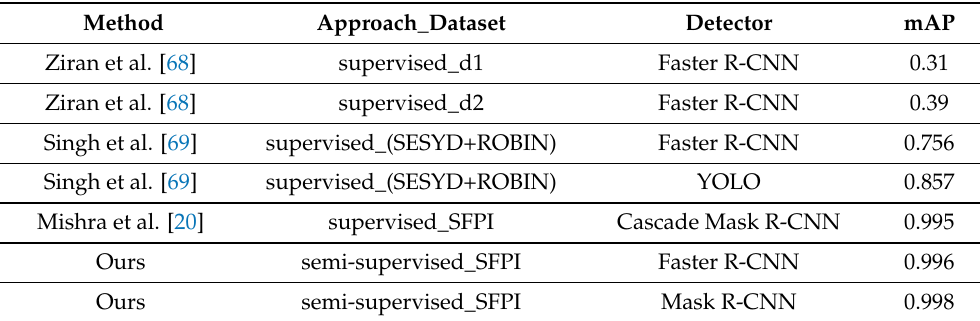
Table 5. Previously compared supervised detectors with our semi-supervised approach that is trained on the floor-plan dataset using Mask R-CNN [17] and Faster R-CNN [25] with